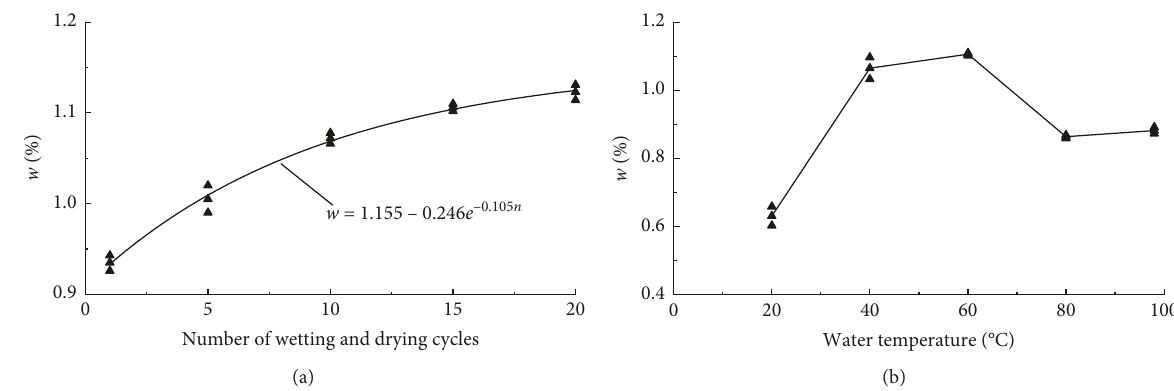
Figure 6: Water content variation after cyclic wetting and drying treatment. (a) Water content versus the number of wetting and drying cycles. (b) Water content versus water